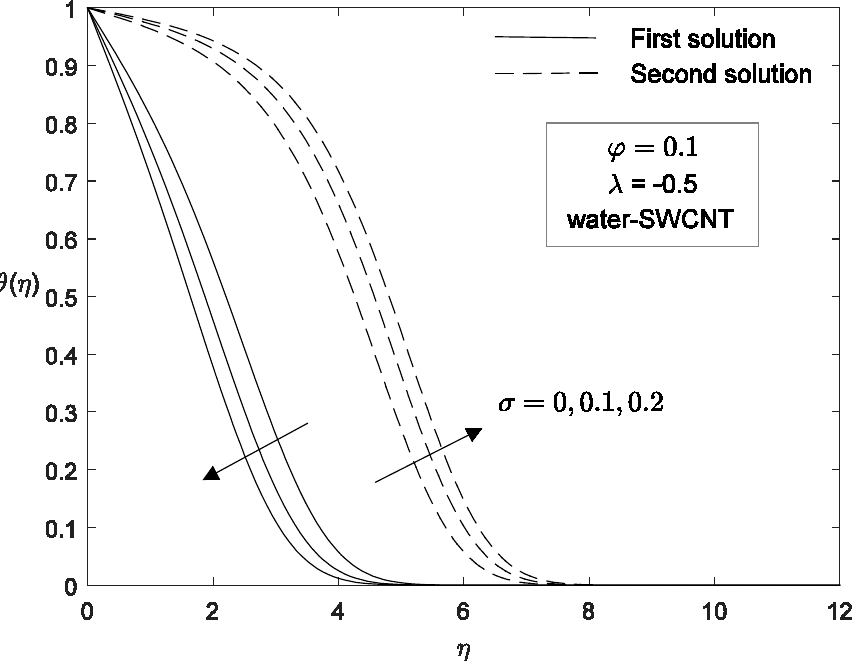
Figure 21. Effect of various σ on temperature profile.